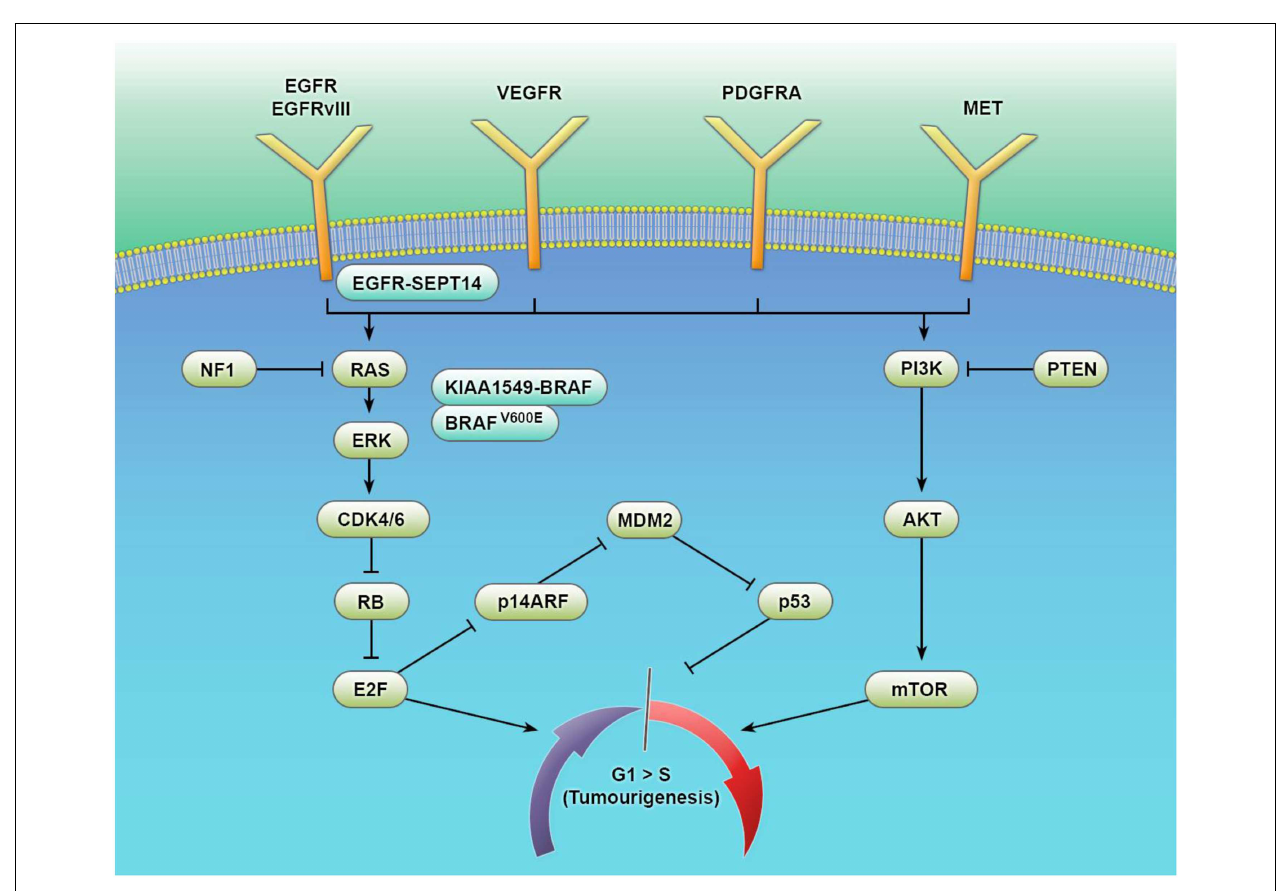
converges on a number of common signaling pathways with considerable cross talk. Increased understanding of these pathways and their interactions is facilitating a biomarker-driven approach to glial tumor biology – improving diagnosis, prognostic estimation, and the development of targeted